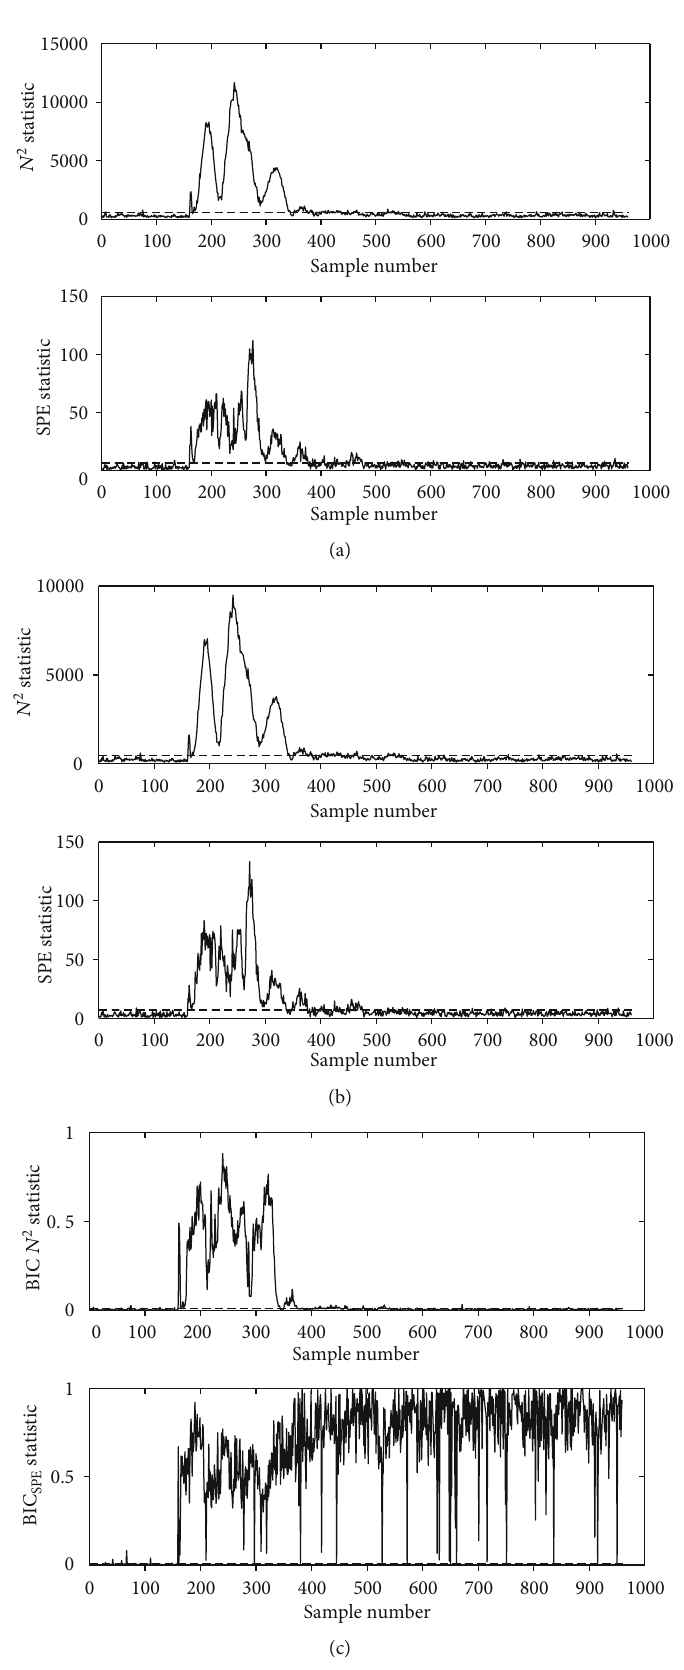
Figure 5: Fault detection results: (a) NMF method; (b) PNMF method; and (c) MPNMF